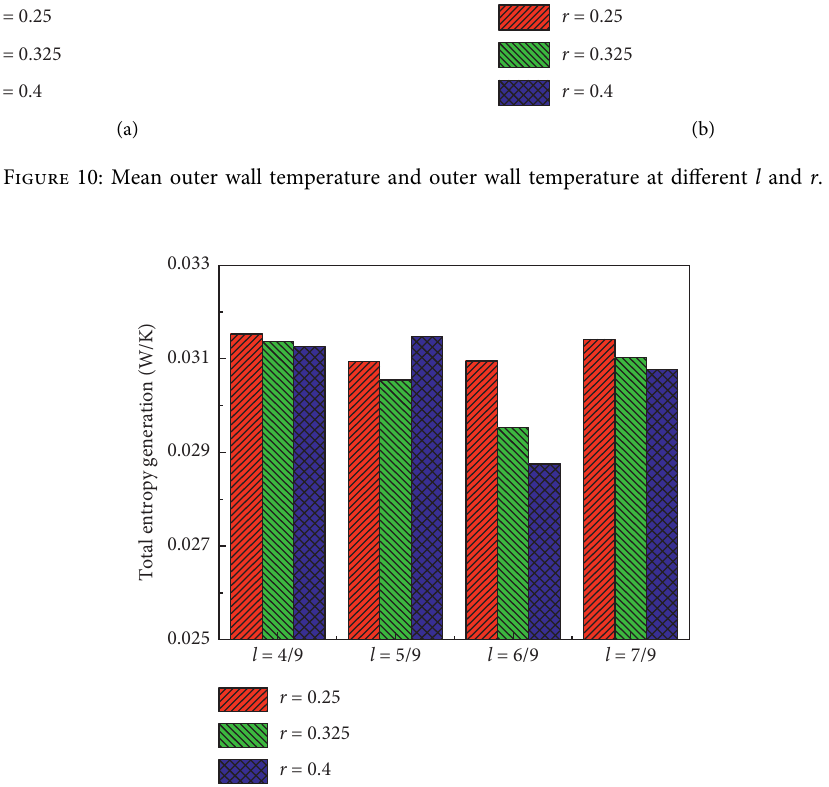
Figure 11: Total entropy generation under various l and r